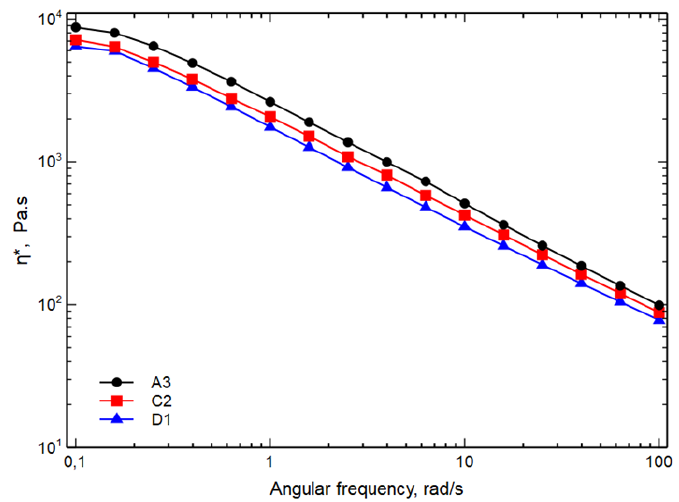
Figure 2. Complex viscosity as function of the frequency of the samples A3, C2 and D1 .